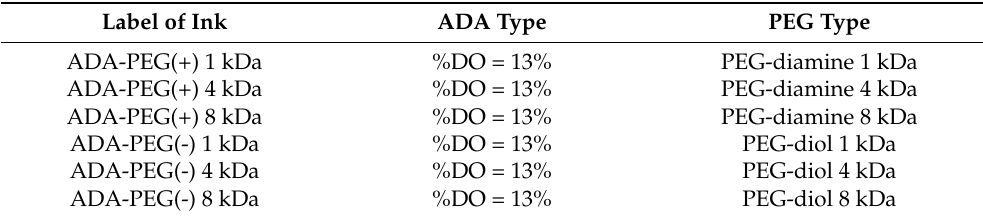
Table 2. List of used ADA-PEG inks and information about their components consisting of ADA with a degree of oxidation of 13% and different PEG types (molecular weight = 1–8 kDa). Label of Ink ADA